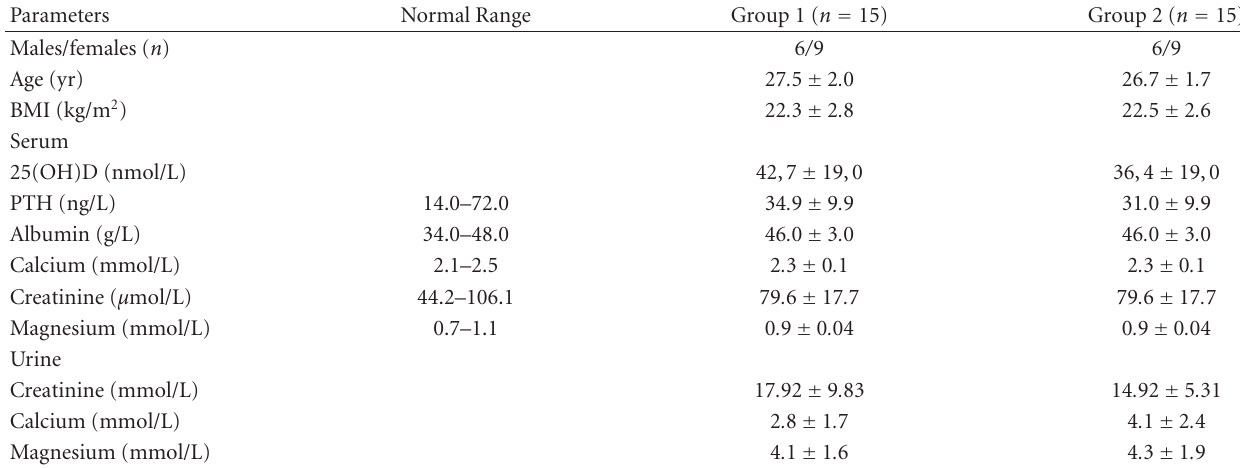
Table 2: Baseline characteristics of the study groups.